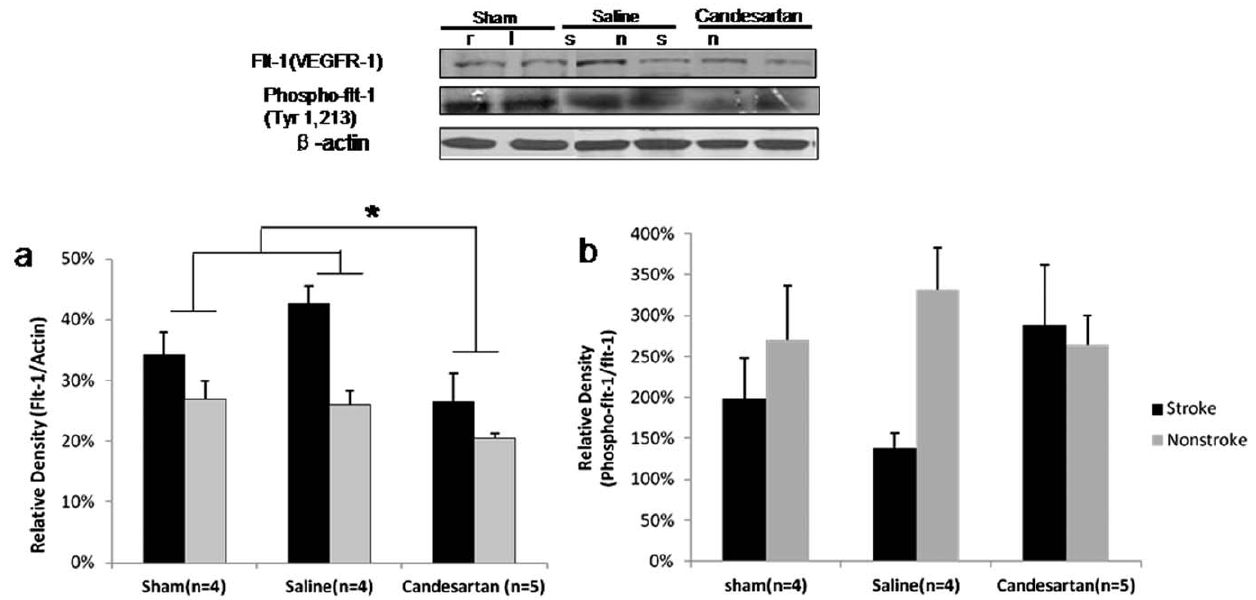
Figure 6. VEGFR-1 expression in the brain. Treatment with candesartan significantly decreased VEGFR1(flt-1) expression in both hemispheres compared with saline-treated or sham animals (Figure 6a, *P , 0.05). VEGFR1 activation, as determined by their phosphorylation status, was not significantly different among sham animals, candesartan, and saline-treated animals (Figure 6b). Candesartan treatment appeared to visually increase VEGFR1 activation in the stroke side, but this did not achieve significance (Figure